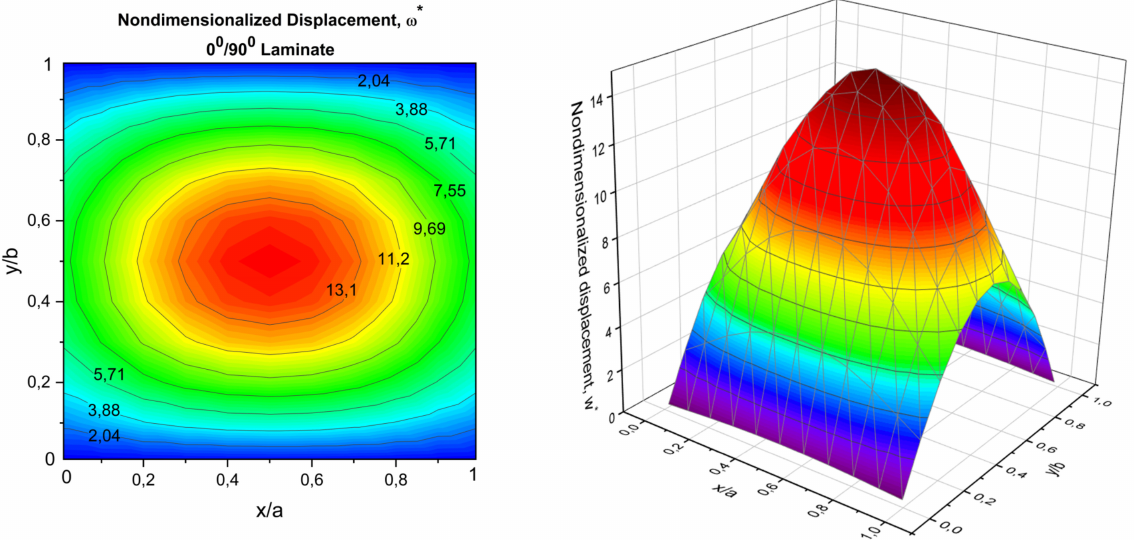
Figure 11. Variations of the non-dimensional displacements, w ∗ , of a moderately thick ( a / h = 20) shell panel (R/ a = 10) and of antisymmetric [0 ◦ /90 ◦ ] cross-ply spherical panels along the panel surface.